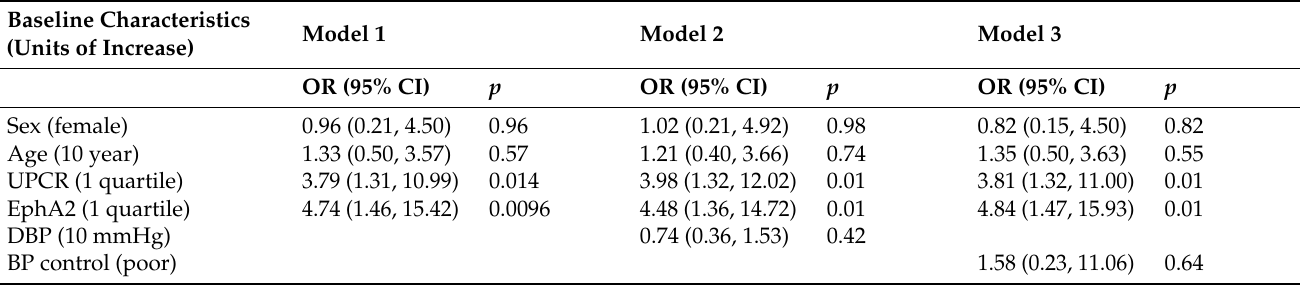
Table 4. Multivariate logistic regression model of risk for lower eGFR in hypertensive patients according to clinical predictors and serum EphA2.